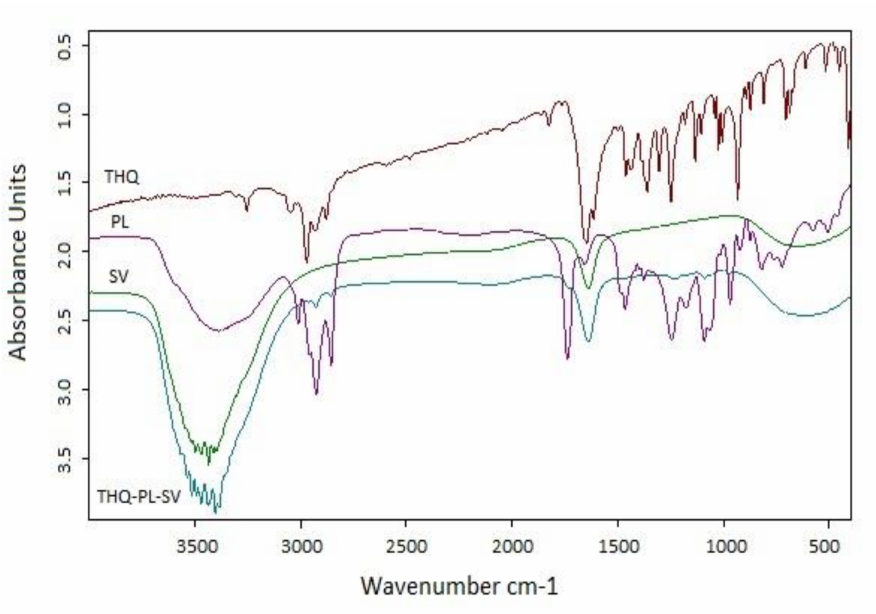
Figure 3. FTIR spectra of THQ, PL, SV, and optimized THQ–PL–SV. Abbreviations: THQ, thymo- quinone; PL, Phospholipon ® 90H; SV, scorpion venom